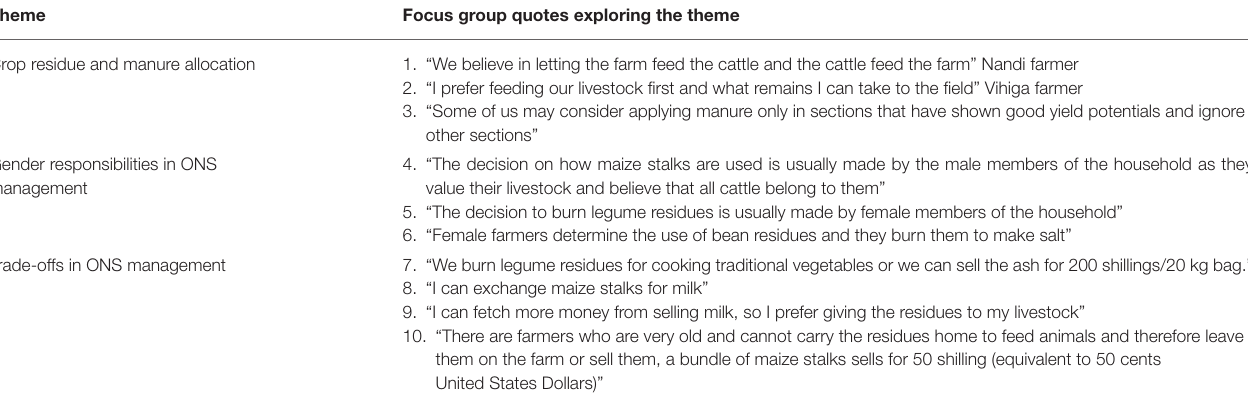
TABLE 5 | Farmer quotes on organic nutrient source management, responsibilities and trade-offs following focus group discussions in Nandi, Vihiga and Busia counties in western Kenya in July 2018. Theme Focus group quotes exploring the